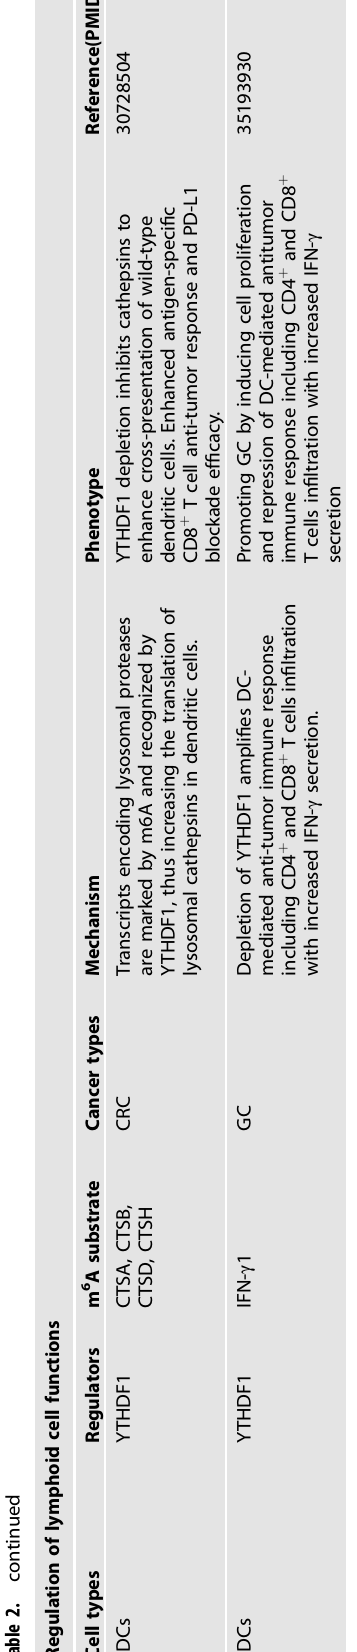
derived suppressor cell accumulation. Thus, ALKBH5 knockout in CRC cells enhance ef fi cacy of immunotherapy and pro-longed mouse survival time. Similarly in CRC models, higher expression of YTHDF1 recognizes m 6 A modi fi ed PD-L1 and VISTA to enhance their stability, thus serving as the ideal target to promote the in fi ltration of CD8 + T cells, when synergizing with PD-1 blockade [134]. Considering its the potential effects on immune evasion, T a